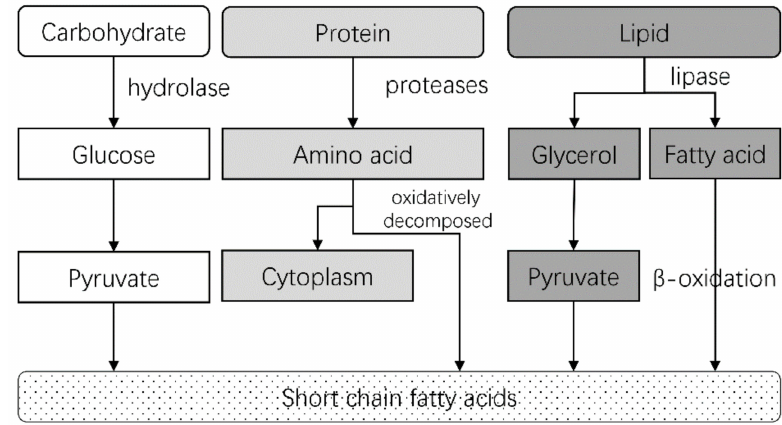
Figure 1. Fermentation pathways of major organic substances in food